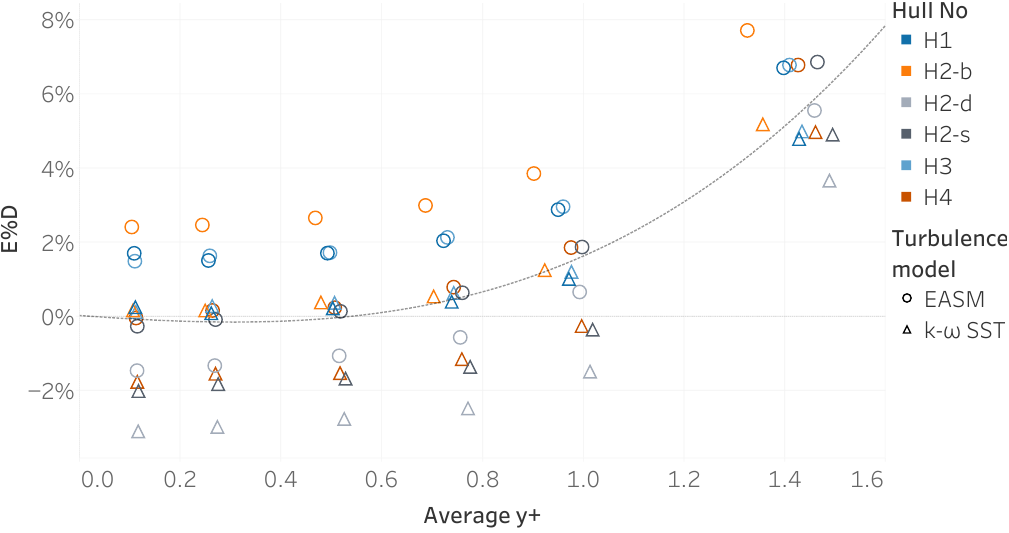
Figure 3. Comparison error of all test cases for average y +